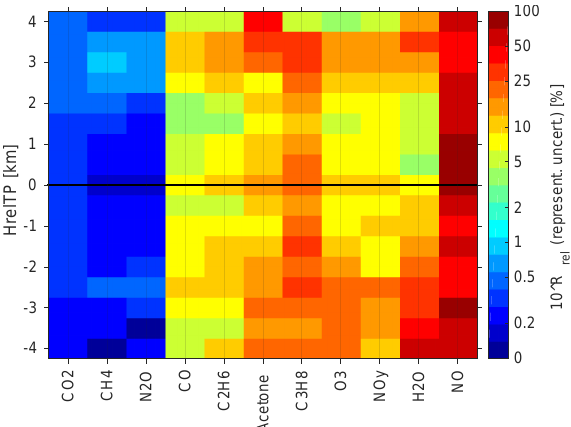
Figure 9. Representativeness uncertainty for using the CARIBIC data (that is 334 long-distance flights, see Table 1) to com- pile a climatology: 10 R rel calculated from MOD RANDLOC and MOD sampled . Low values indicate small representativeness un- CARIBIC certainties. N 2 O, C 2 H 6 and C 3 H 8 are measured from air samples, which increases the uncertainty, especially for C 3 H 8